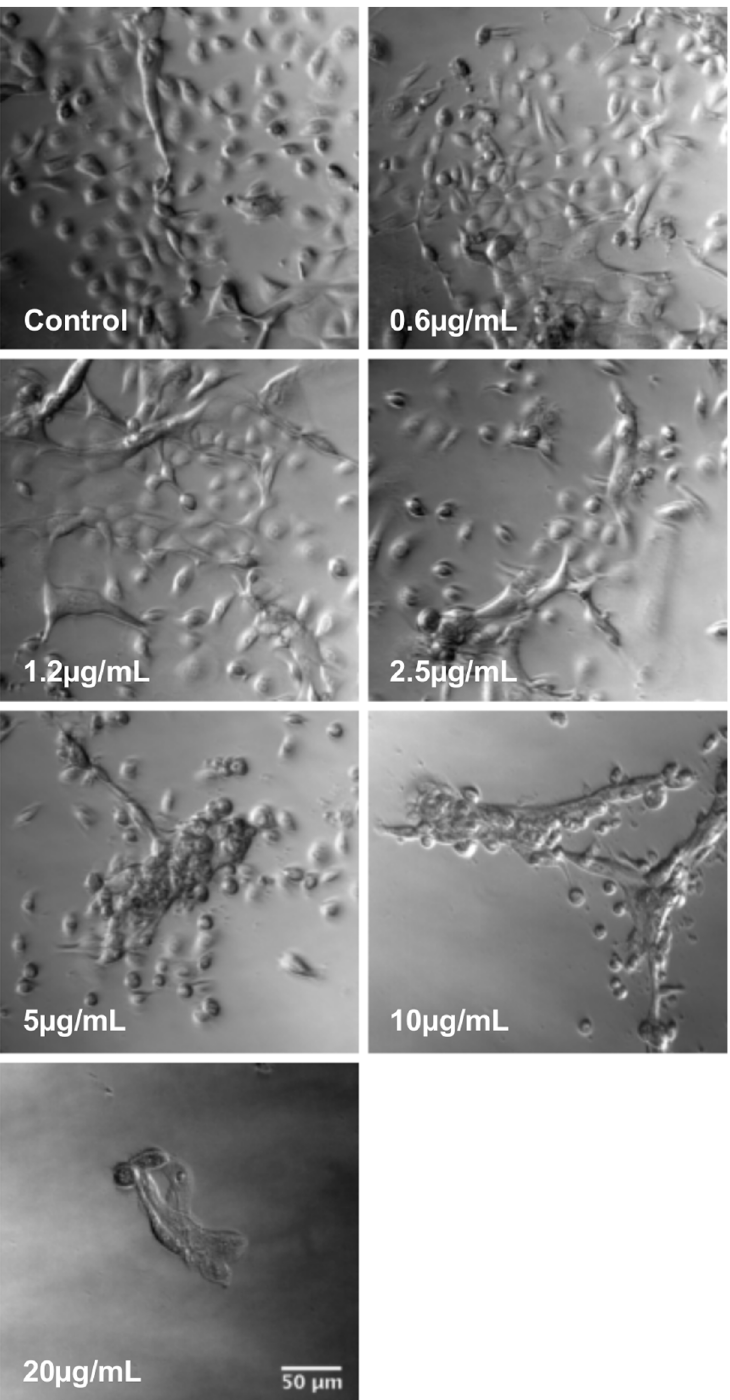
Fig 2. Morphological changes in keratinocytes after treatment with L . m . muta venom. Cells were treated for 24 hours with serial dilutions of venom (0.6–20 μ g/mL). Control group was kept in culture medium for the same period of time. Images were acquired using widefield Zeiss Axio Observer microscope. Scale bar = 50μm.